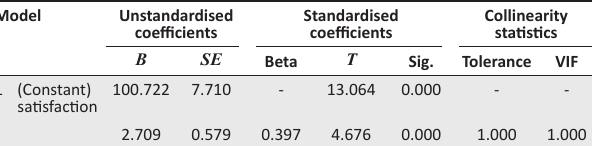
TABLE 9: Analysis of variance summary results for the total classroom climate scores by class.